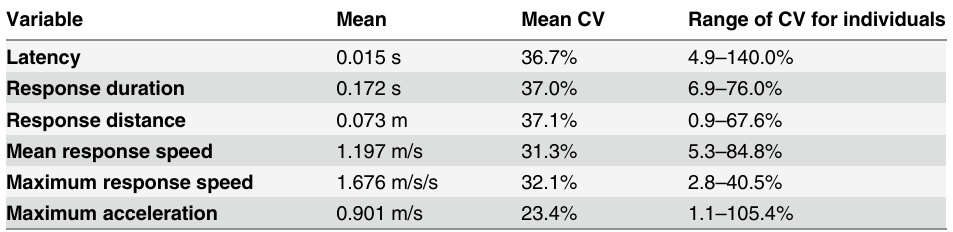
Table 1. Kinematics of the escape response of Acanthochromis polyacanthus juveniles indicating their mean response, mean coefficient of variation (CV) and range of CV at the individual level esti- mated from 3 consecutive bursts per